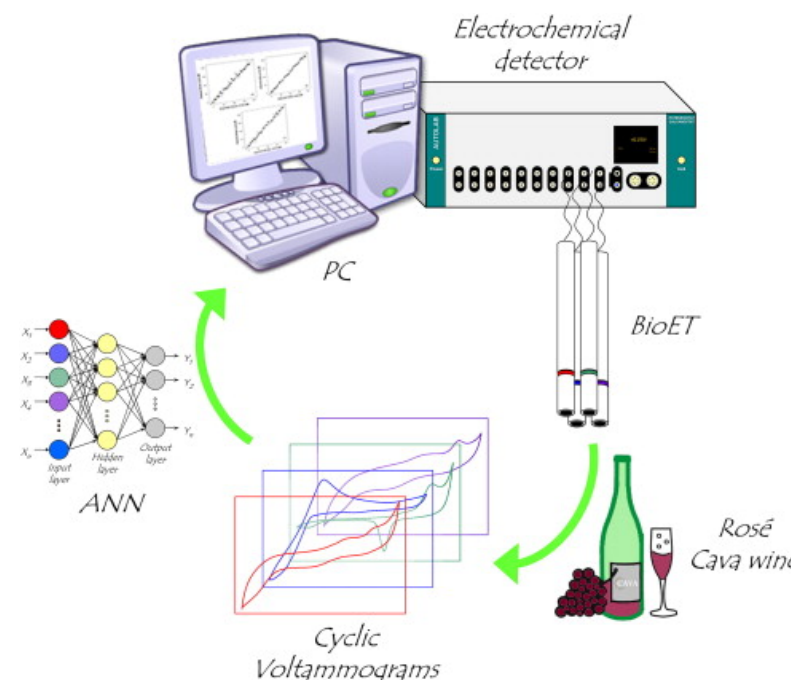
Figure 5. Schematic representation of the BioET approach (reproduced from [59] with permission of Elsevier Publishing).